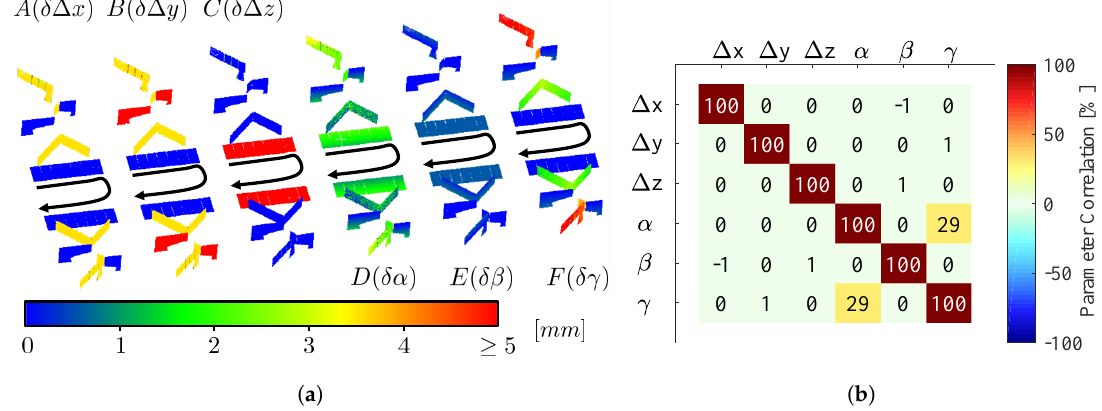
Figure 6. ( a ) Sensitivity of the plane setup towards deviation of the calibration parameters. The plots show the point-to-plane distance when the lever arm or the boresight angles deviate from their true values: A ( δ ∆ x = 5 mm), B ( δ ∆ y = 5 mm), C ( δ ∆ z = 5 mm), D ( δα = 0.05 ◦ ), E ( δβ = 0.05 ◦ ), and F ( δγ = 0.05 ◦ ) ( b ) The calibration parameters are basically uncorrelated and, thus, clearly separable. Only the boresight angles α and γ show a small correlation of 29 % (explanation in the